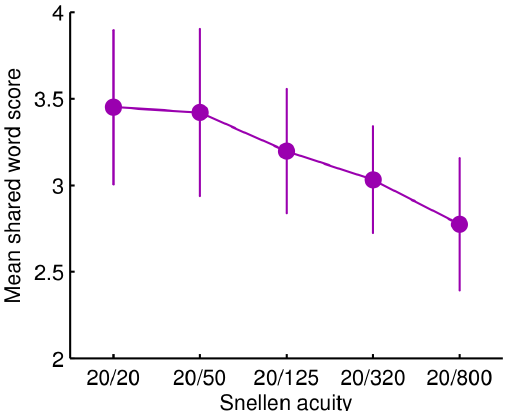
Figure 3. Effect of visual acuity on shared word score. Mean number of words shared with responses to the same clip in the lab- sourced dataset, for different levels of visual acuity as achieved with defocus lenses. Error bars indicate 95% confidence intervals.